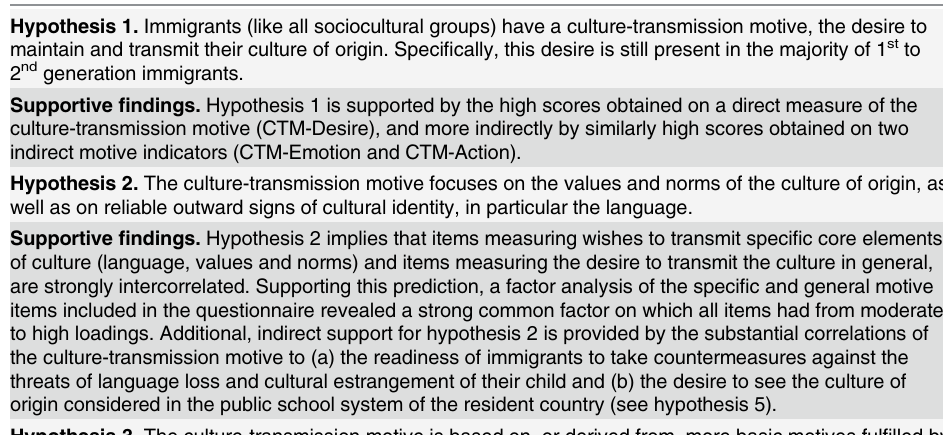
Table 1. Hypotheses and Main Supportive